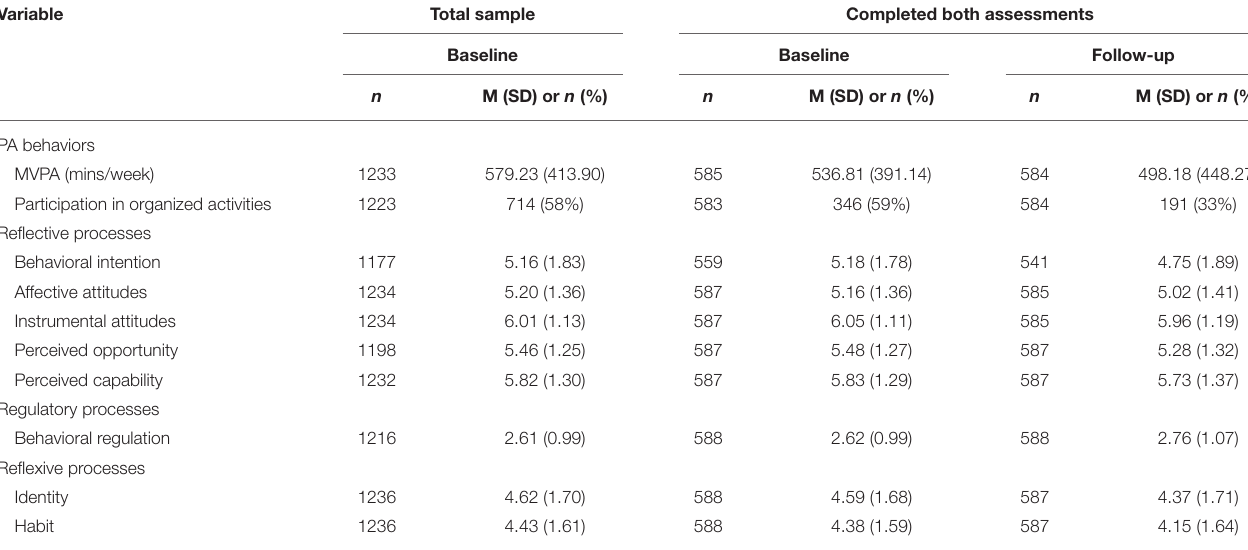
TABLE 2 | Descriptive statistics for PA behaviors and PA cognitions at baseline and follow-up. Variable